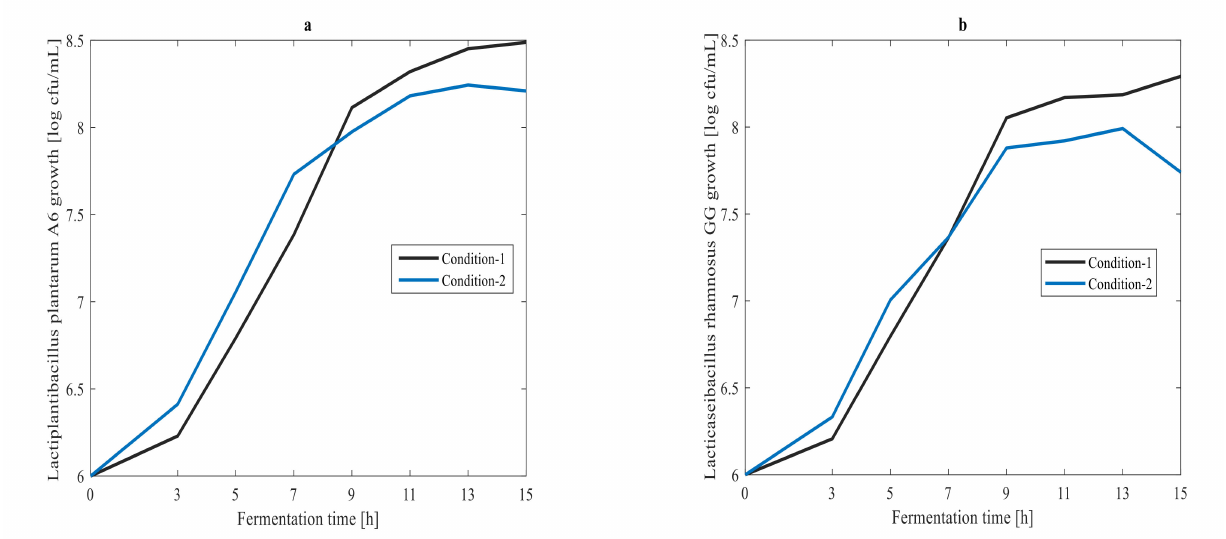
Figure 1. ( a ) Lactiplantibacillus plantarum A6 and ( b ) Lacticaseibacillus rhamnosus GG growth under two different fermentation conditions: Condition 1, 7 g/100 mL substrate inoculated with 6 log cfu/mL mixed strains of Lactiplantibacillus plantarum A6 and Lacticaseibacillus rhamnosus GG; Condition 2, 4 g/100 mL substrate inoculated with 6 log cfu/mL mixed strains of Lactiplantibacillus plantarum A6 and Lacticaseibacillus rhamnosus GG.